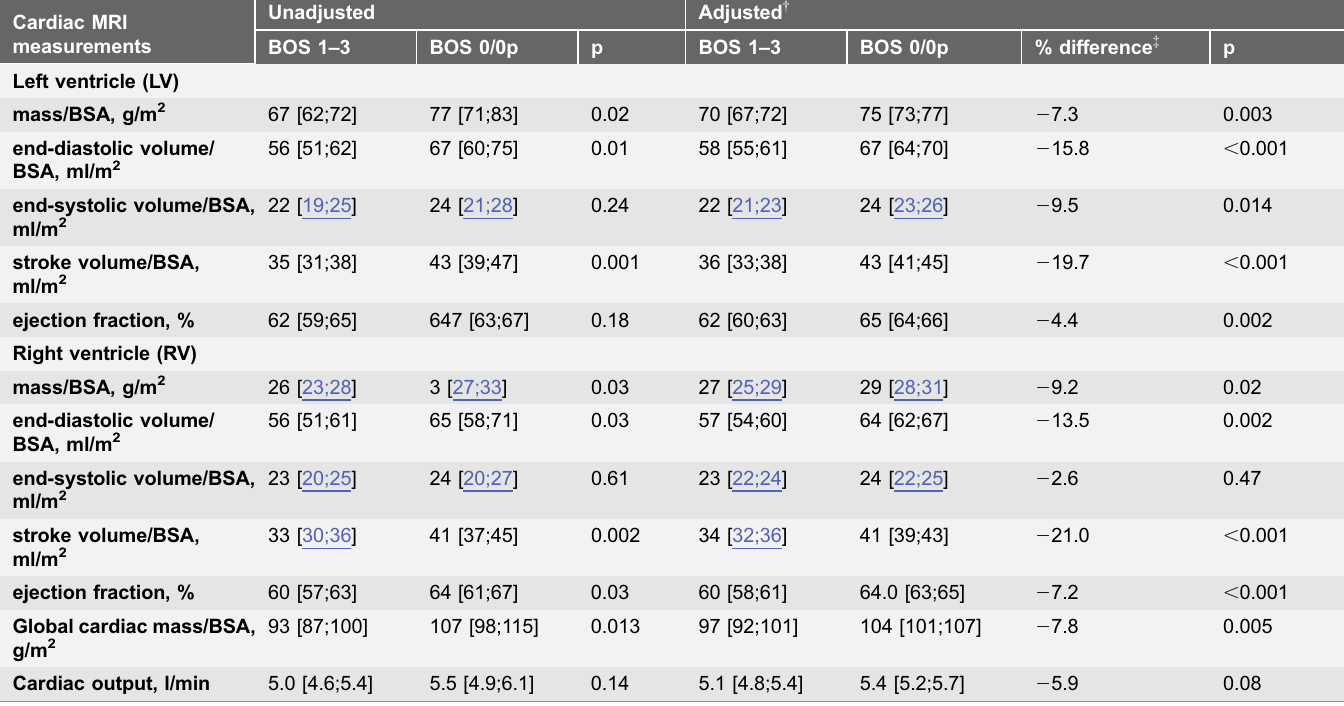
Table 2. Cardiac magnetic resonance imaging (MRI): unadjusted and adjusted values of cardiac structure and function according to bronchiolitis obliterans (BOS) status*. Cardiac MRI